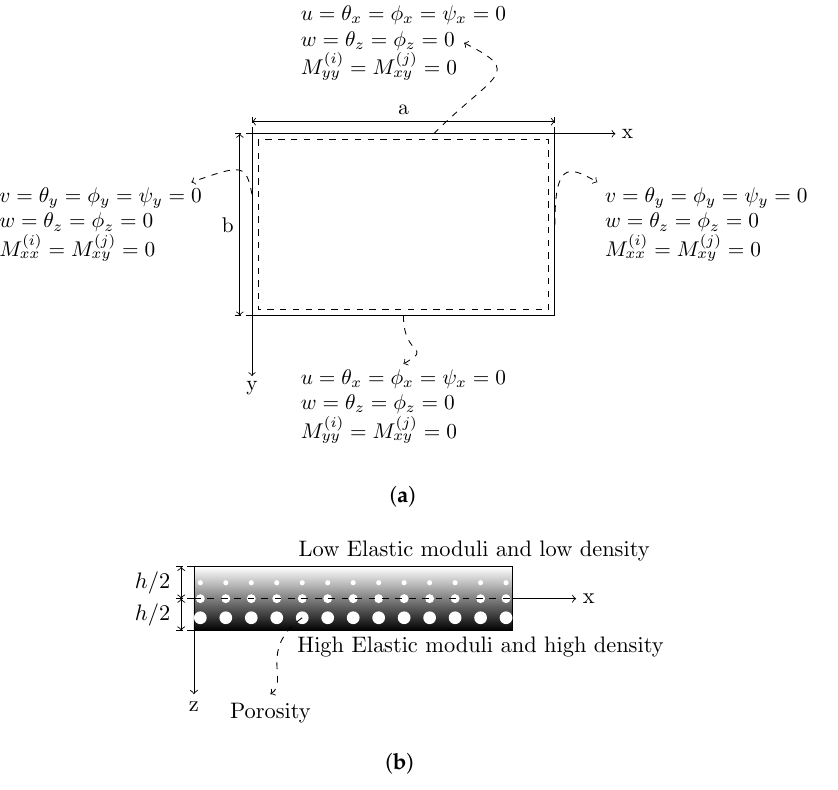
Figure 2. Boundary conditions of the simply supported plate [50] (where i = 0, 1, 2, 3 and j = 0, 1, 2) ( a ) and the cross-section of the FGPM plate (Type 3) ( b